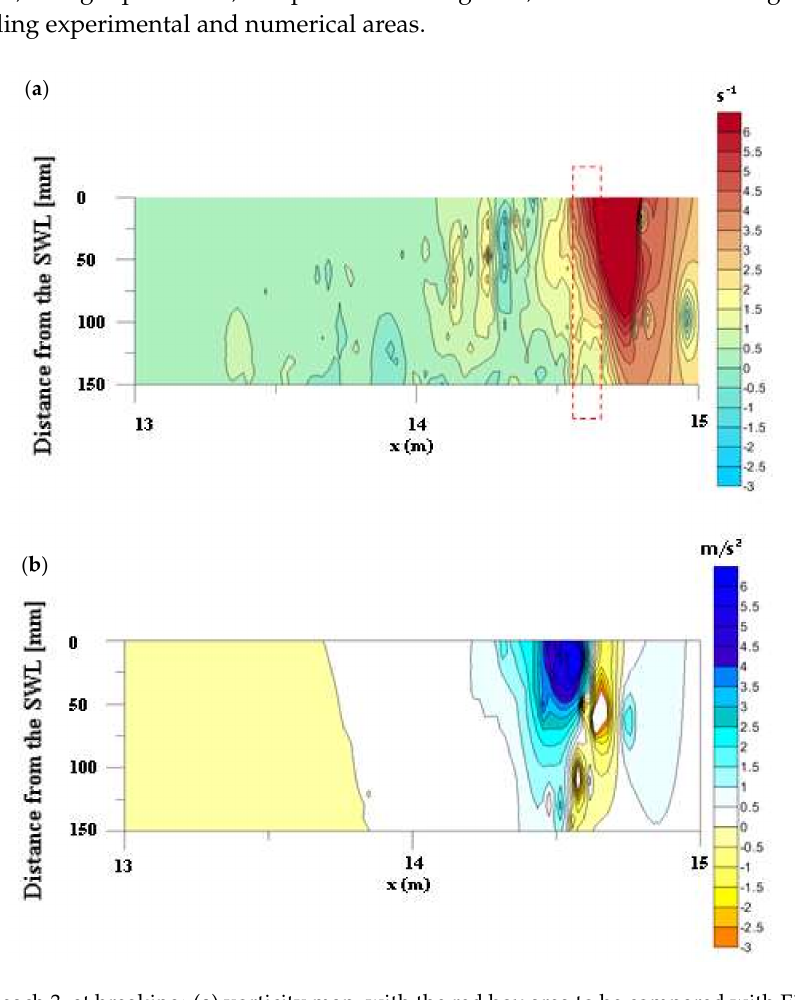
Figure 9. Reach 3, at breaking: ( a ) vorticity map, with the red box area to be compared with Figure 7a,b, ( b ) surface-parallel convective acceleration